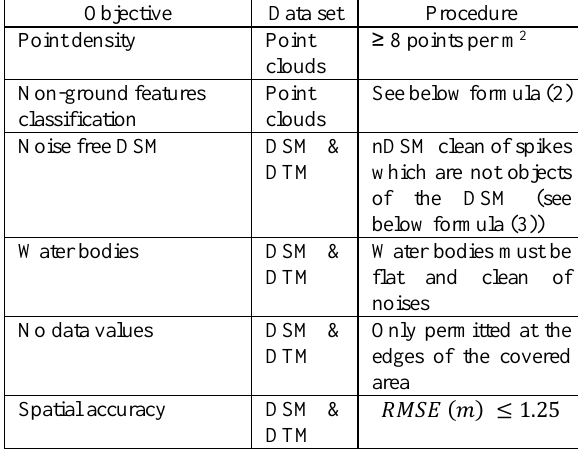
Table 6: Chapter C DTM&DSM QC procedures (2)